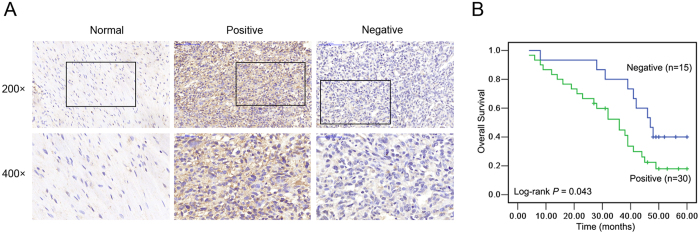
TRIM14 is correlated with poor prognosis in human osteosarcoma.(A) Representative images of TRIM14 expression in osteosarcoma specimens (middle and right) and normal bone tissues (left) examined by IHC. (B) Influence of TRIM14 expression patterns on overall survival estimated with Kaplan-Meier analyses.